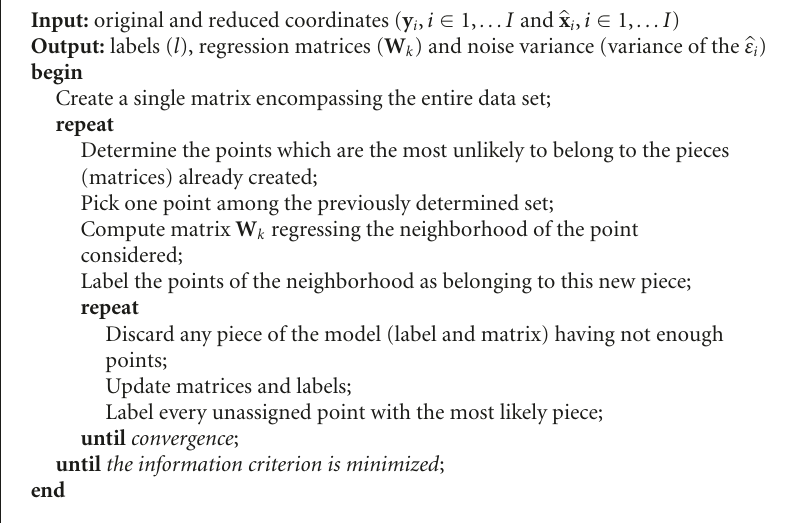
preserved in the reduced space (see Figure 2 and